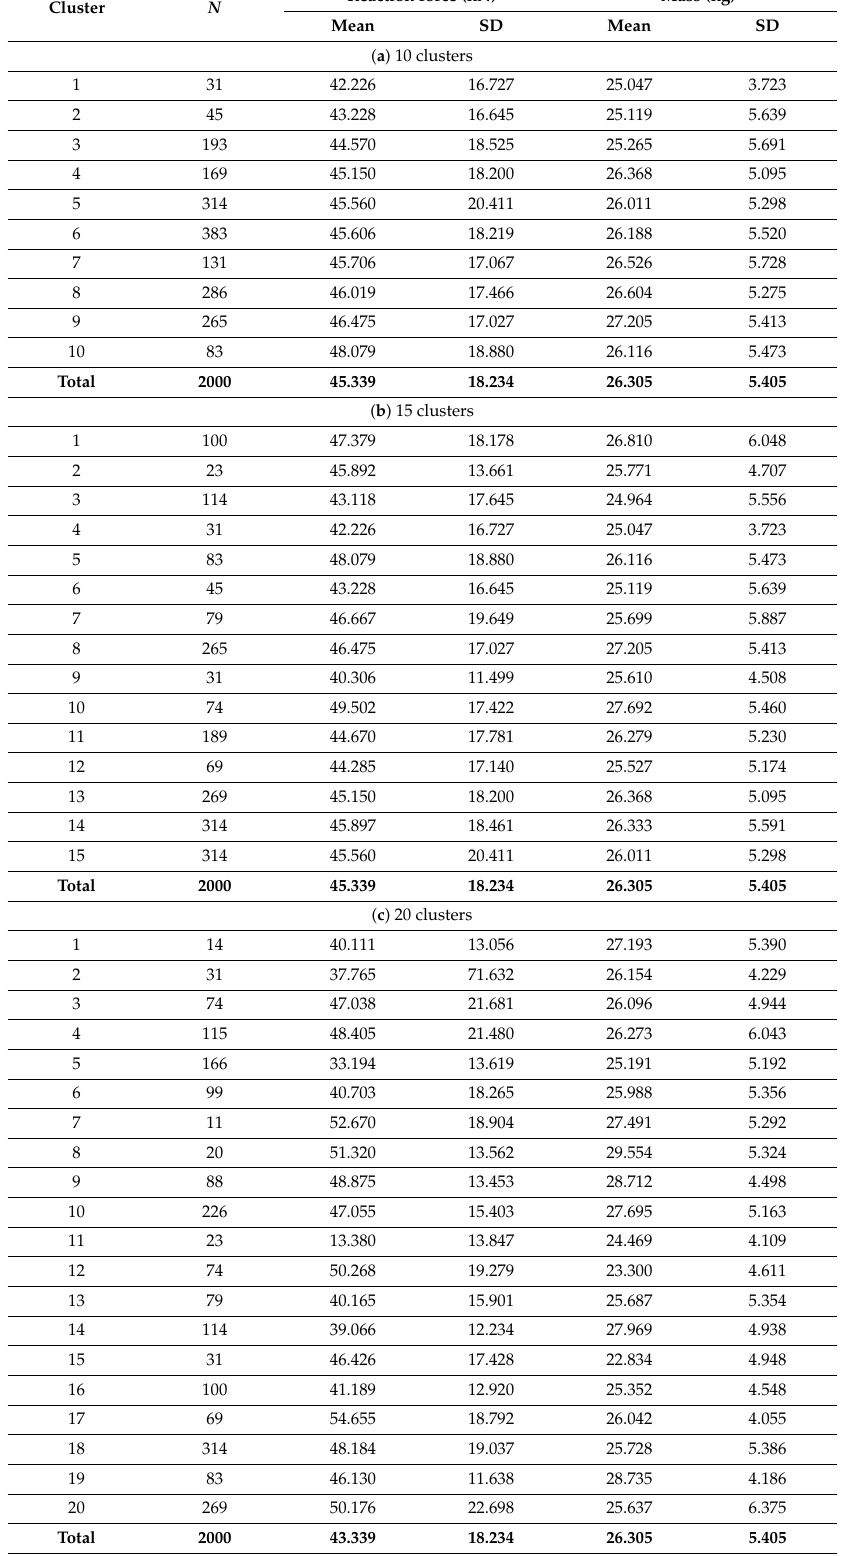
Table 4. Three types of clustering obtained from 2000 BIW models ( a ) 10 clusters; ( b ) 15 clusters; and ( c ) 20